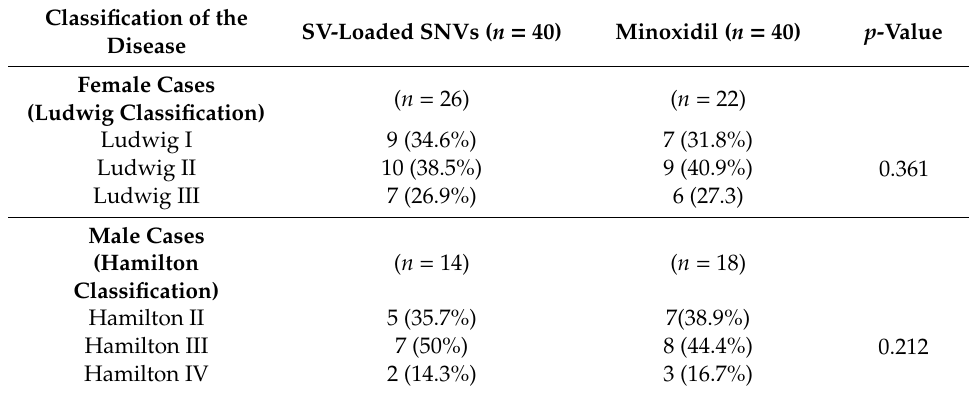
Table 7. Disease classification among the studied groups.